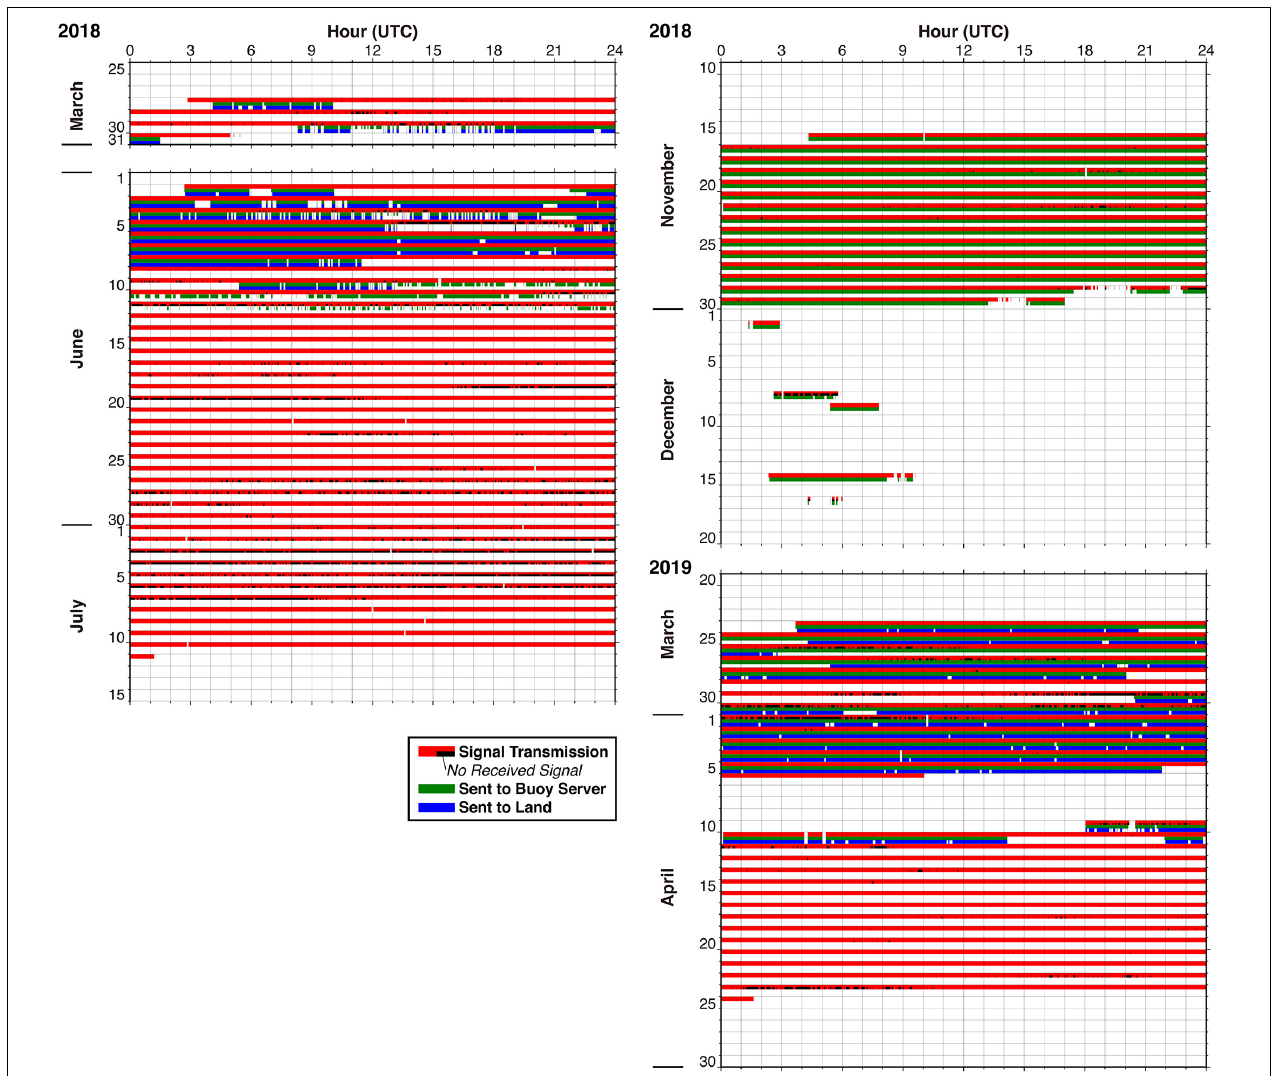
FIGURE 6 | Diagram showing the status of acoustic ranging test. Red: buoy-mounted acoustic ranging controller transmitted the acoustic signal to the ocean bottom transponder, black: nothing was recorded at the acoustic ranging controller (the signal receiving was failed), green: the acoustic waveform was sent to the signal processing computer, blue: the acoustic waveform was sent to the data storage server at the ground base station via the satellite